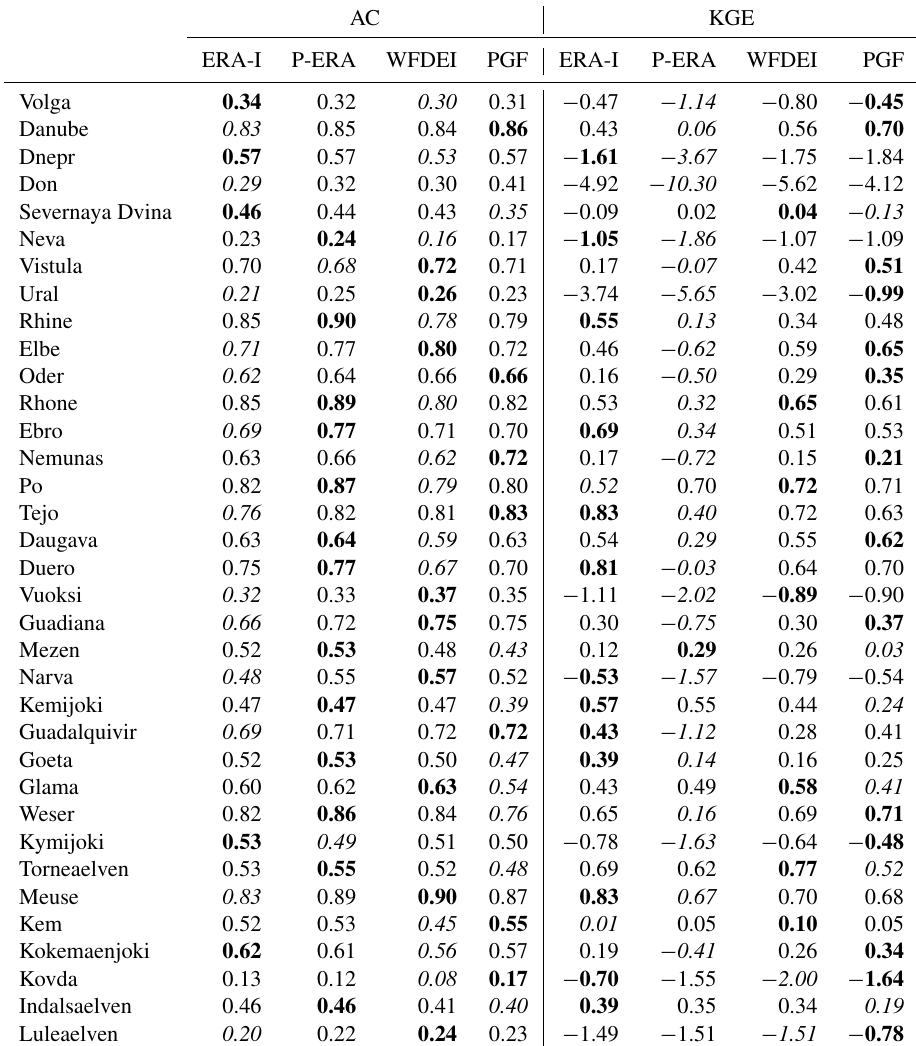
Table 2. River discharge scores (AC, KGE) computed at downstream GRDC gauges. For each gauge and score pair, the best (worst) simula- tion is highlighted in bold